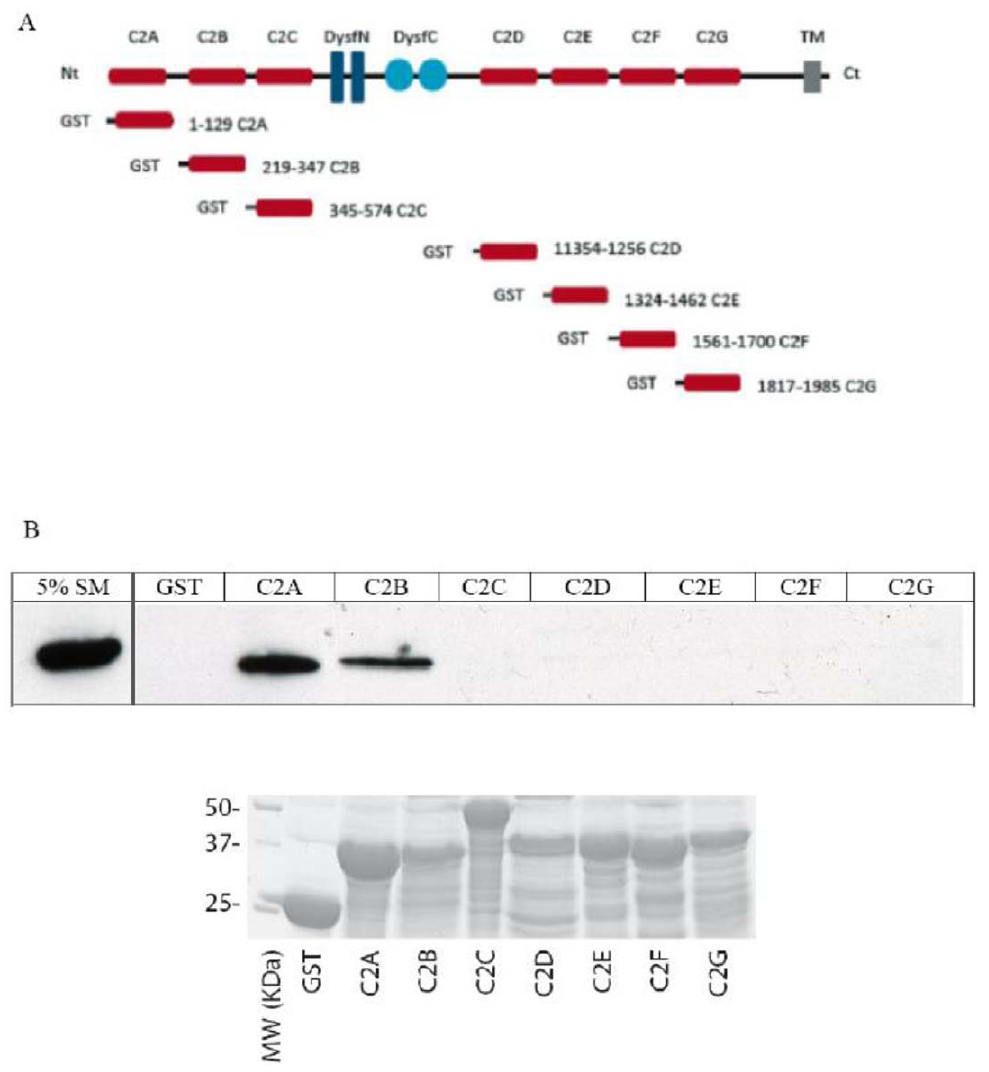
Figure 4. Alpha-tubulin interacts with dysferlin through the C2A and C2B domains. A. Schematic illustration of full-length wild type dysferlin and the various GST-C2 domain constructs used. B. C2C12 myoblast extract was incubated with GST alone or with the various GST-C2 domains precoupled to glutathione-Sepharose 4B beads. The bound proteins were separated on SDS-PAGE followed by Western blot analysis using anti-alpha-tubulin antibody. SM: standard material. Lower panel: nitrocellulose membrane of GST-dysferlin C2 domains with adsorbed proteins from the cell extract stained with ponceau red.